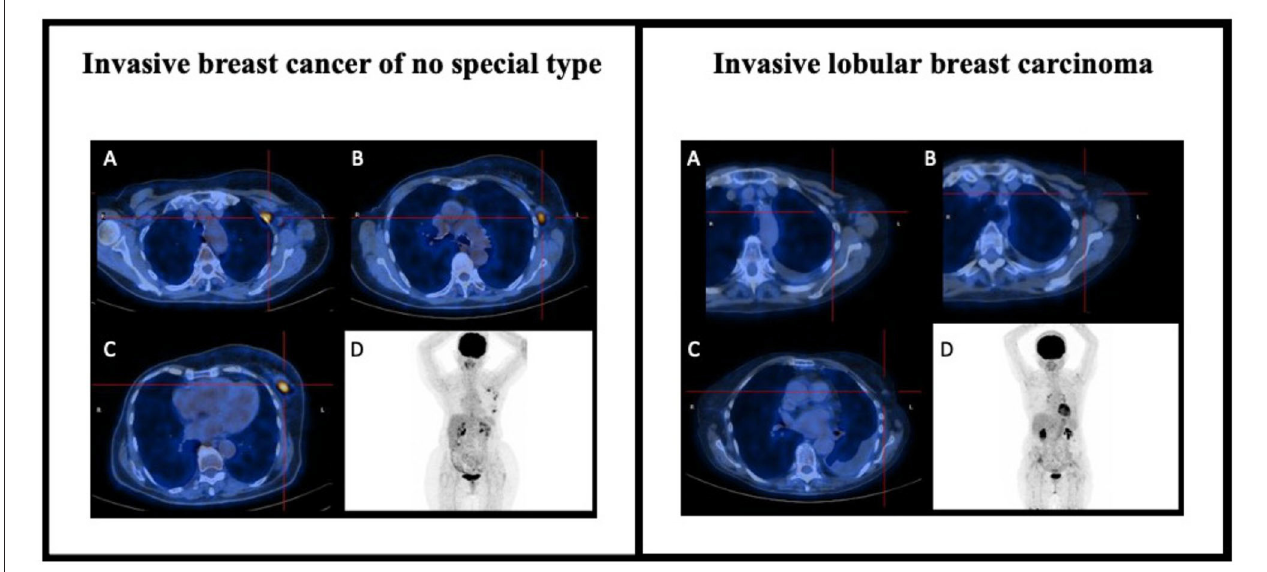
FIGURE 3 | [ 18 F]F-FDG PET/CT in BC staging. On the left, the case of an 83-year-old lady with previous in situ BC on the right and suspected recurrence of breast cancer on the left. Staging [ 18 F]F-FDG PET/CT scan showed focal and elevated uptake at the level of the breast lesion on the left upper-external quadrant (C) and at the level of several ipsilateral axillary lymph nodes suspected for secondary localization of disease (A,B) , as also shown in the MIP images (D) . The cytologic finding was consistent with the clinical suspicion of IBC-NST recurrence (ER 98%, PR 99%, anti-Ki67 23%, anti c-erbB2 negative). On the right, the case of a 72-year-old lady hospitalized for dyspnea and CT findings of right pleural effusion concomitant to left mammary nodule and mediastinal lymphadenopathies. Staging PET scans did not show any FDG uptake in the suspicious lesions reported on CT scan, either in the breast (C) or in the ipsilateral axillary lymph nodes (A,B) , as also shown in MIP images (D) . The cytological findings were consistent with the clinical suspicion of ILBC (ER 78%, PR 55%, anti-Ki67 46%, anti c-erbB2 negative).